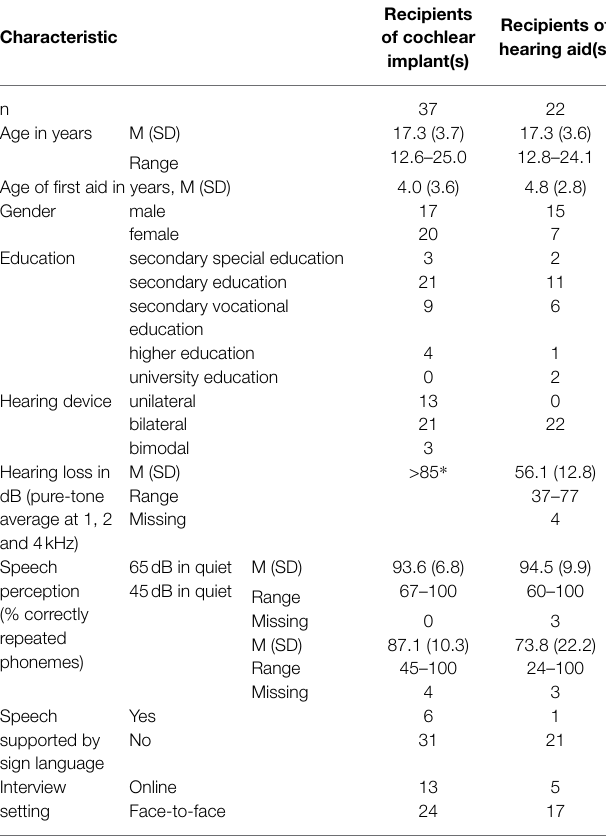
TABLE 1 | Demographic characteristics of the respondents, distinguishing recipients of hearing aids, and cochlear implants.